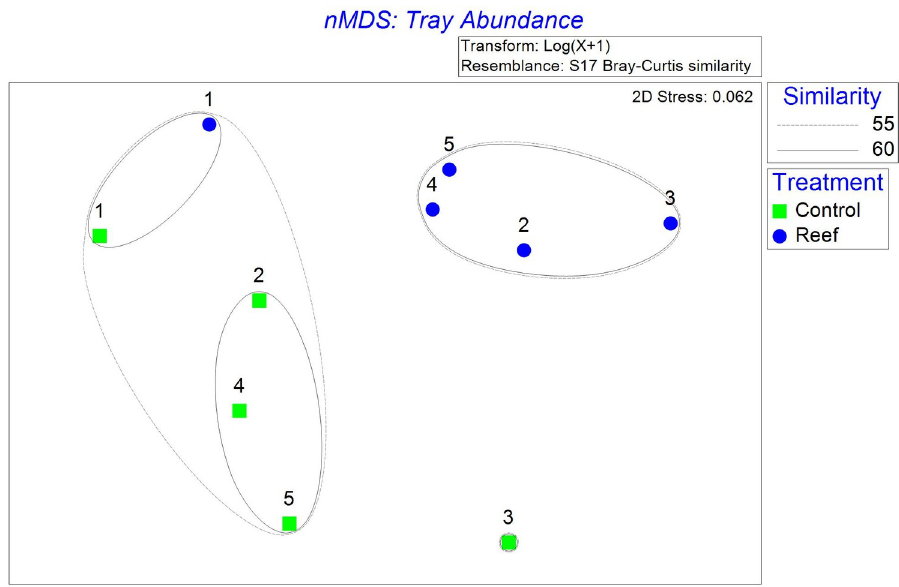
Fig 6. nMDS plot of resident motile fauna communities at constructed reef and control sites in years 1, 2, 3, 4, and 5 years after reef construction. Ellipses in the plot represent percent similarity of communities from cluster